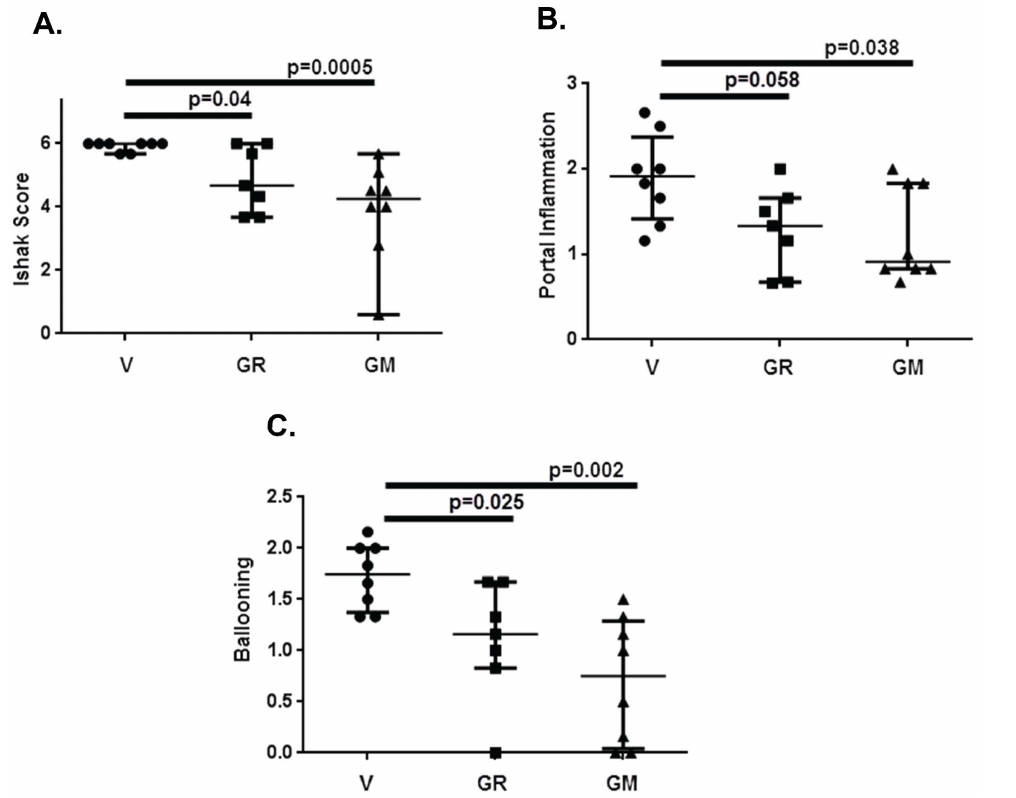
Figure 7. Histological analysis of liver sections from groups 1(V), 4 (GR) and 7 (GM) from experiment described in Figure 4. Liver histology from each animal was evaluated in a blinded fashion by an experienced pathologist as described in Materials and Methods. Statistical analysis was done using Mann-Whitney test for non-parametric measurements and the graph show median with interquartile range. A : Ishak Score; B: Portal Inflammation; C: Ballooning degeneration of hepatocytes.